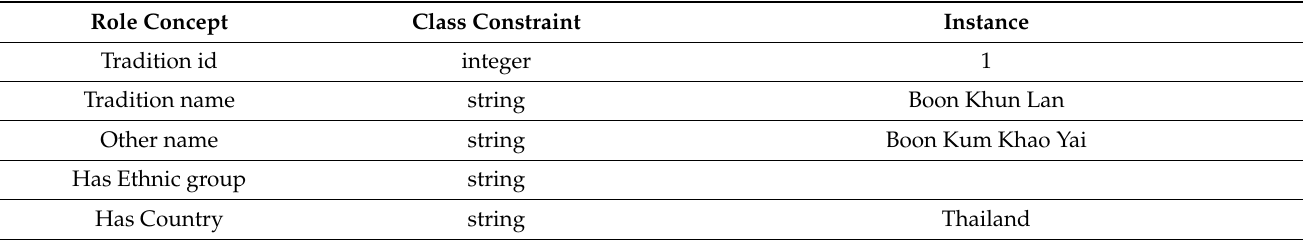
Table 2. An example of creating